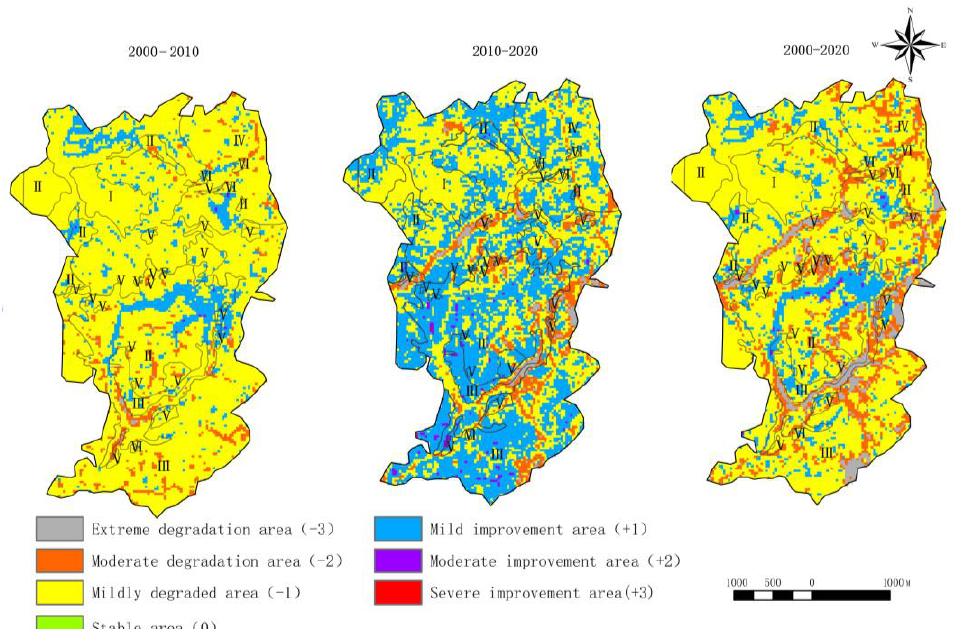
Figure 4. Distribution map of absolute change of vegetation coverage in Nanhu Scenic Area from 2000 to 2020. Note: I is a special protection zone, II is a scenic tour area, III is a scenic restoration area, IV is a scenic coordination area, V is a tourism service area, and VI is a development control area.